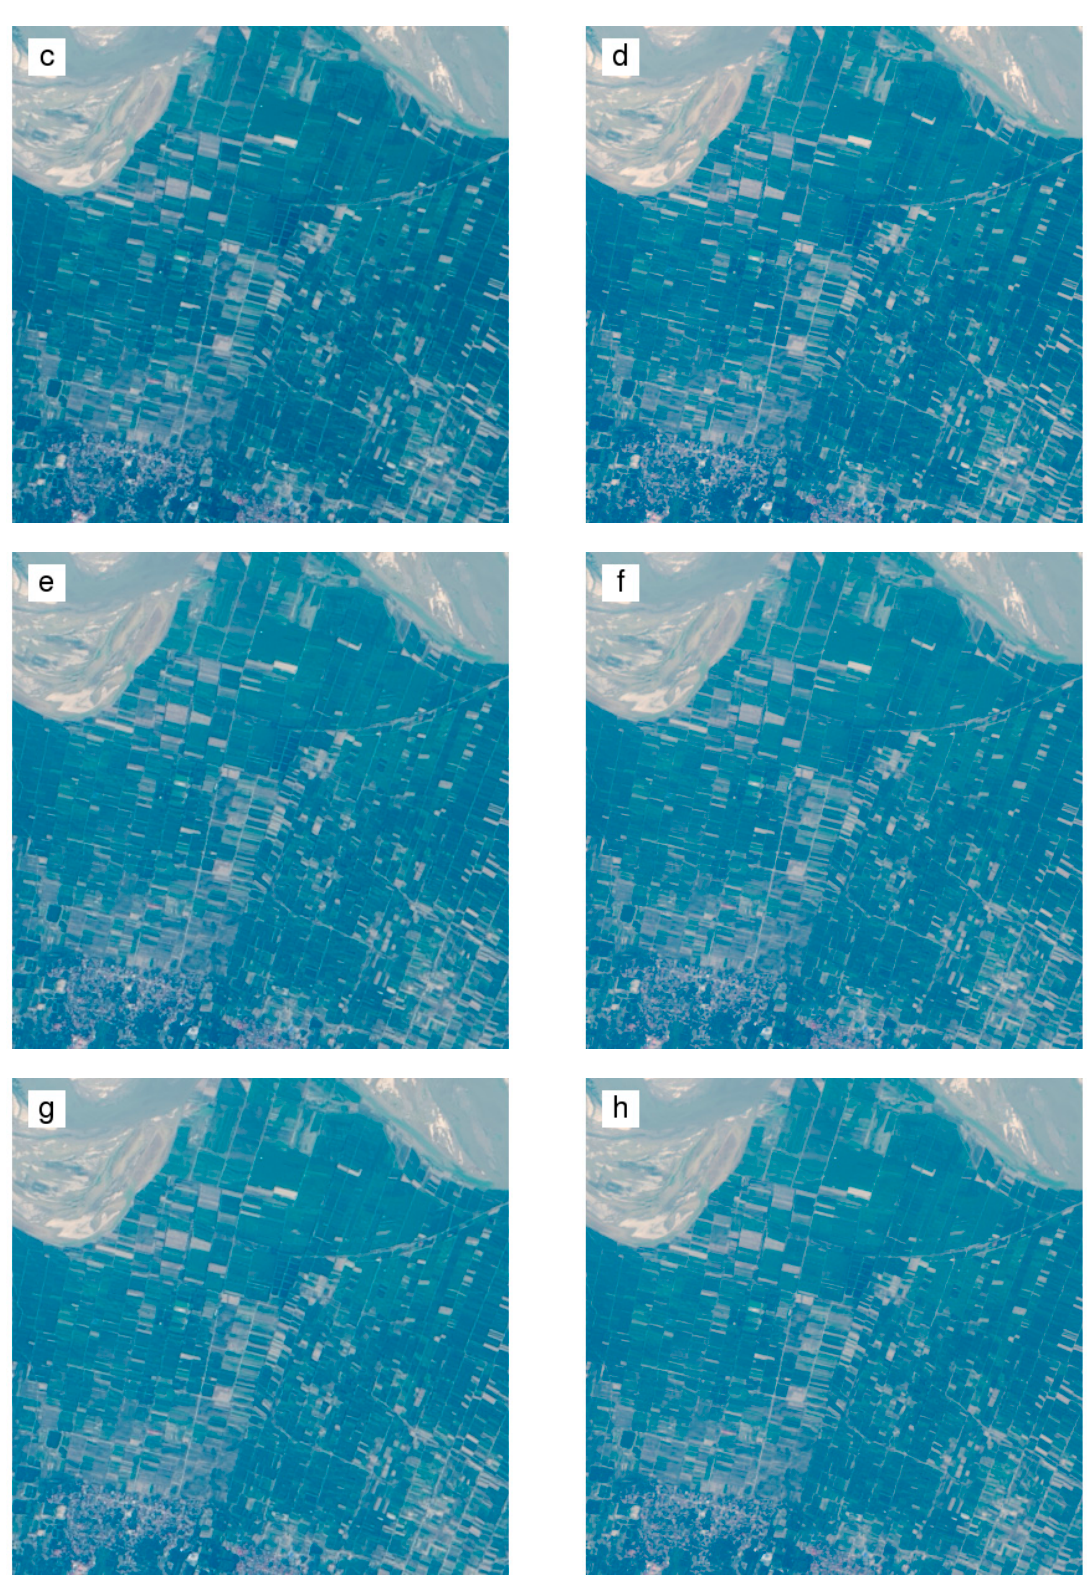
Figure 7. China illustrative 400 × 400 (15 m) subset. Top row: 15 m TOA panchromatic reflectance ( a ) and 30 m true color (red, green and blue) TOA reflectance cubic convolution resampled to 15 m ( b ); The following rows show 15 m true color Brovey (left column) and context adaptive Gramm-Schmidt (right column) pansharpened reflectance respectively, derived using intensity images computed using the equal ( c , d ); spectral response function based (SRFB) ( e , f ); and image specific spectral weights ( g , h ) summarized in the Figure 4 caption.